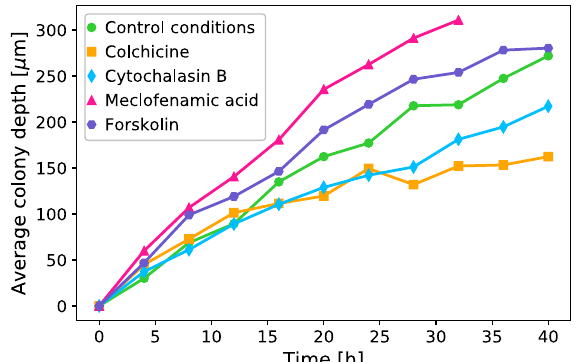
Figure 3. Dynamics of proliferating Rat1 epithelial cell fronts. Average colony depth as a function of time, showing the speed of proliferation is strongly affected by pharmacological